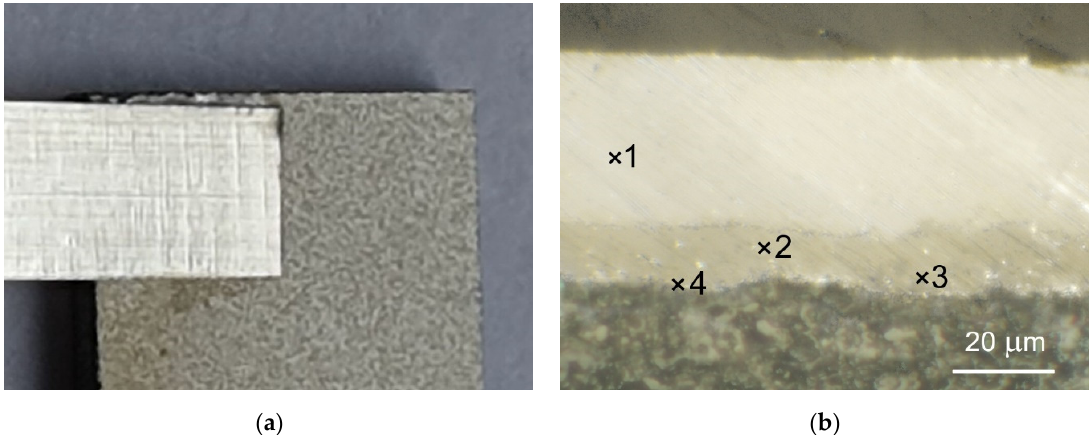
Figure 9. Microscopic pictures of a sample C: ( a ) overall view of joint; ( b ) cross-section of joint with phase composition of different areas: 1—Ag; 2—33.8 at.% Ag, 66.2 at. % In; 3—54.6 at.% Ag, 45.4 at.% In; 4—49.9 at.% Ag, 50.1 at.% In.